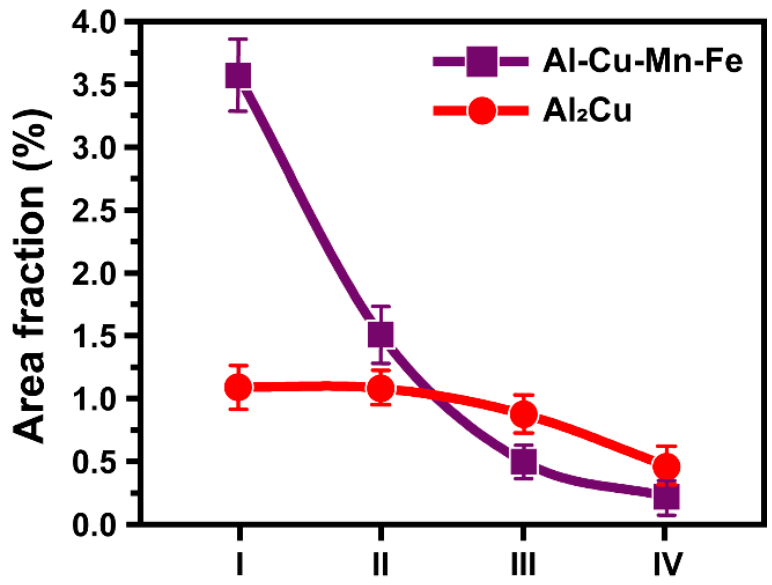
Figure 6. Area fractions of second phases in the synthesized Al alloys .